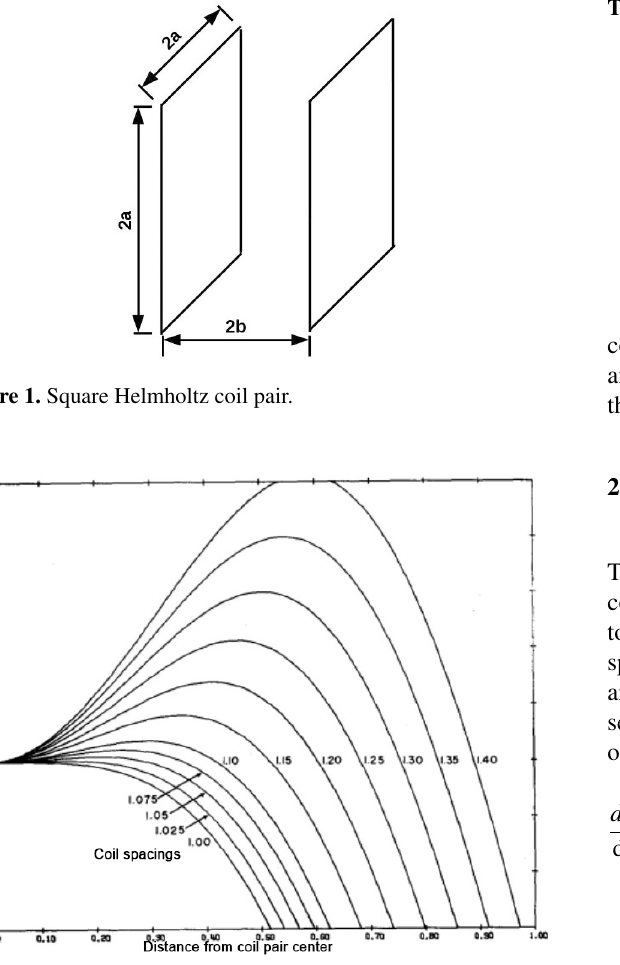
Figure 2. Magnetic field uniformity for a circular coil (Rudd and Craig,